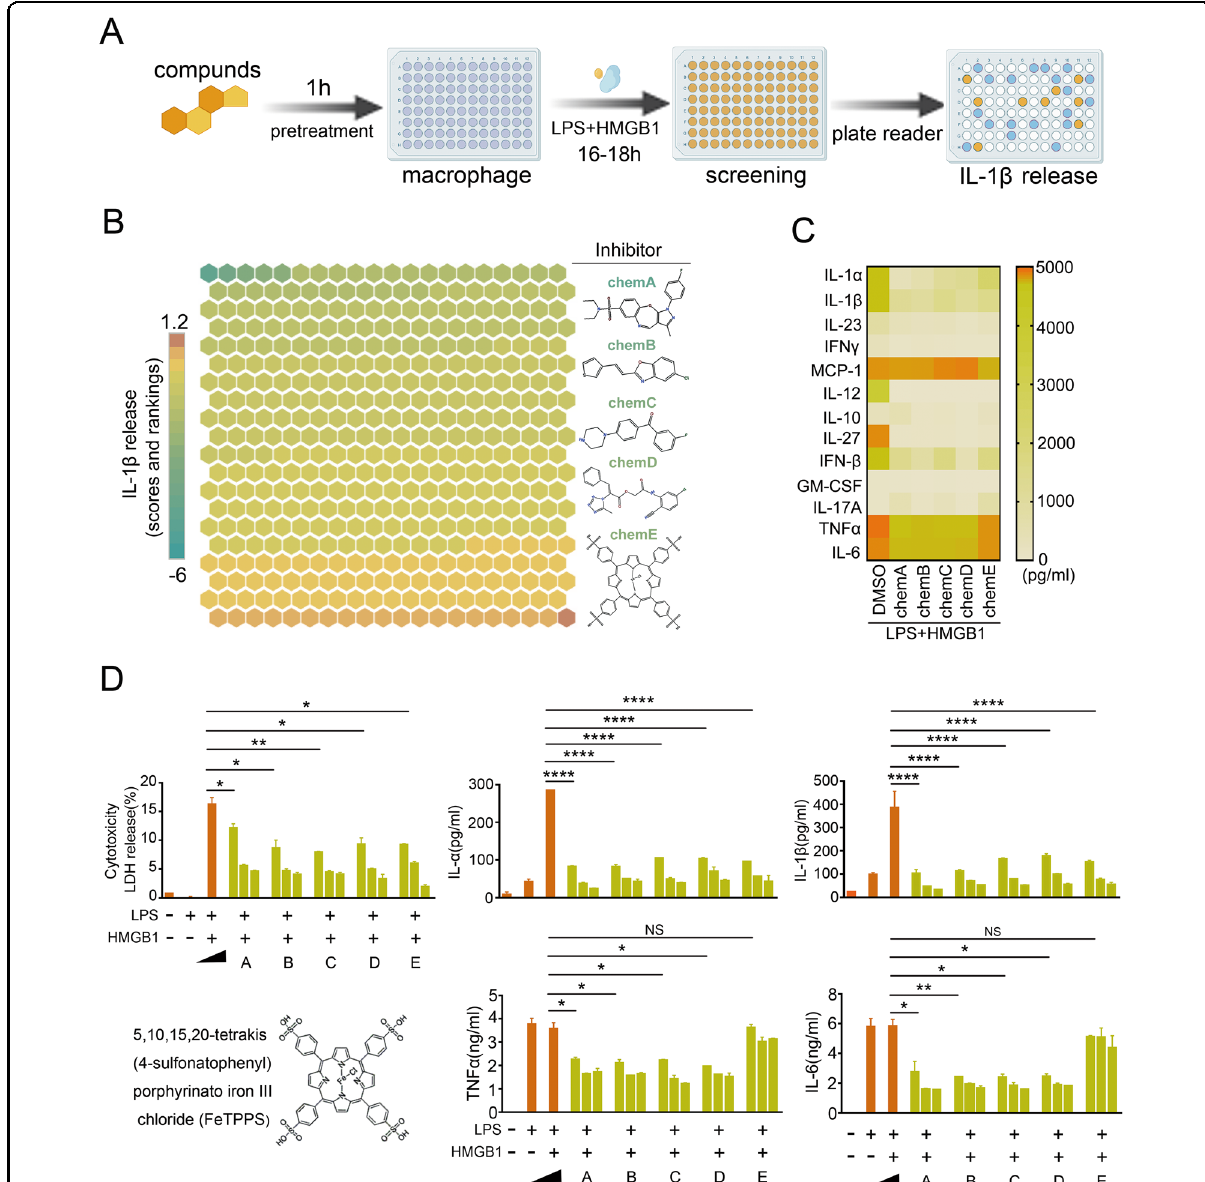
Fig. 1 Identi fi cation of bioactive compounds inhibits the HMGB1-caspase-11 pathway. A A phenotypic screening strategy to identify compounds that inhibit the HMGB1-caspase-11 pathway in mouse macrophages exposed to both recombinant HMGB1 and LPS. B Heatmap of HMGB1-caspase-11 pathway activity changes based on IL-1 β release from mouse peritoneal macrophages after stimulation with LPS (1 μ g/mL) + HMGB1 (400 ng/mL) for 16 h in the absence or presence of 434 bioactive compounds (10 μ M). C Heatmap of cytokine assay in mouse macrophages after stimulation with LPS (1 μ g/mL) + HMGB1 400 ng/mL 16 h in the absence or presence of fi ve small molecules. D LDH Assay and ELISA for IL-1 α , IL-1 β , TNF α , and IL-6 in the supernatants of mouse peritoneal macrophages after stimulation with LPS (1 μ g/mL) + HMGB1 (400 ng/mL) for 16 h in the absence or presence of fi ve small molecules with indicated dose (1, 5, and 10 μ M). Graphs show the mean ± SD of technical replicates and are representative of at least three independent experiments. An unpaired t -test (two-sided) was used (LDH LH vs. LH + A * P = 0.0494; LH vs. LH + B * P = 0.0266; LH vs. LH + C ** P = 0.0095; LH vs. LH + D P = 0.0252; LH vs. LH + E * P = 0.0133; IL-1 α , IL-1 β LH vs. LH + A/B/C/D/E **** P < 0.0001; TNF α LH vs. LH + A * P = 0.0198; LH vs. LH + B * P = 0.0185; LH vs. LH + C * P = 0.0169; LH vs. LH + D P = 0.0119; IL-6 LH vs. LH + A * P = 0.0355; LH vs. LH + B ** P = 0.0088; LH vs. LH + C * P = 0.0103; LH vs. LH + D P = 0.0101). Compound A: N,N-dimethyl-3-{[(2-methylquinazolin-4-yl)sul-fanyl]methylbenzene-1-sulfonamide; Compound B: 5-chloro-2-[2-(thiophen-3-yl)ethe-nyl]-1,3-benzoxazole; Compound C: (5E)-5-{[5-(4-Chlorophenyl)-2-furyl]methylene}-2thioxoimidazolidin-4 4-one; Compoud D: 2-oxo-2-(3-oxo-1,2,3,4-tetrahydroquinoxalin-1-yl) ethyl 2-[(4,4,4- tri fl uoro-3-oxobut-1-en-1-yl) amino] benzoate; Compound E: 5,10,15,20- Tetrakis(4-sulfonatophenyl) porphyrinato Iron (III),